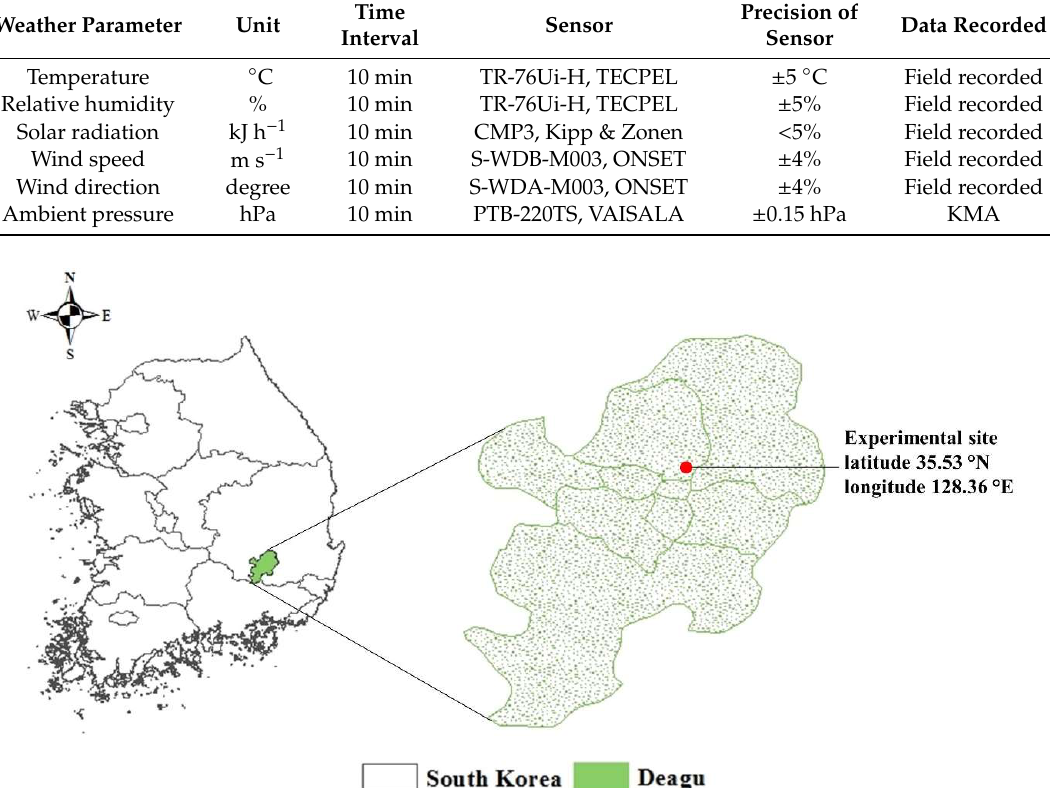
Figure 1. Geographic location of experimental greenhouse